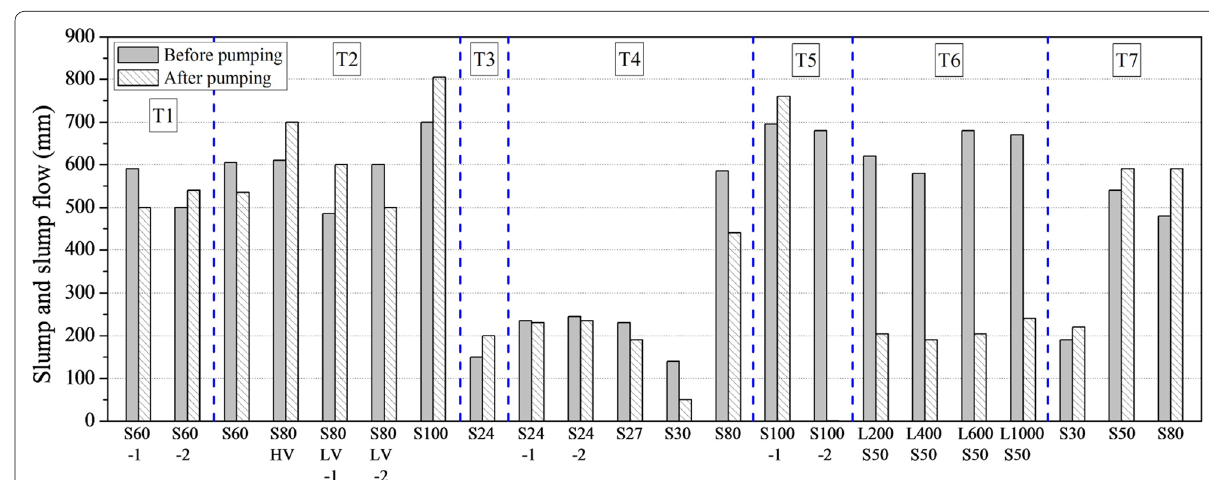
Fig. 2 Results of slump and slump flow from the real-scale pumping